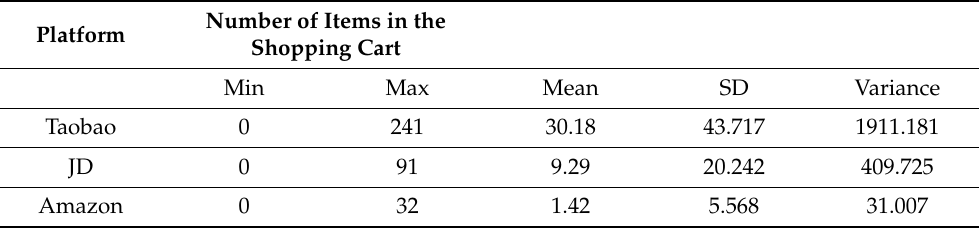
Table 3. Statistics of abandoned items in online shopping carts of the three major online shopping